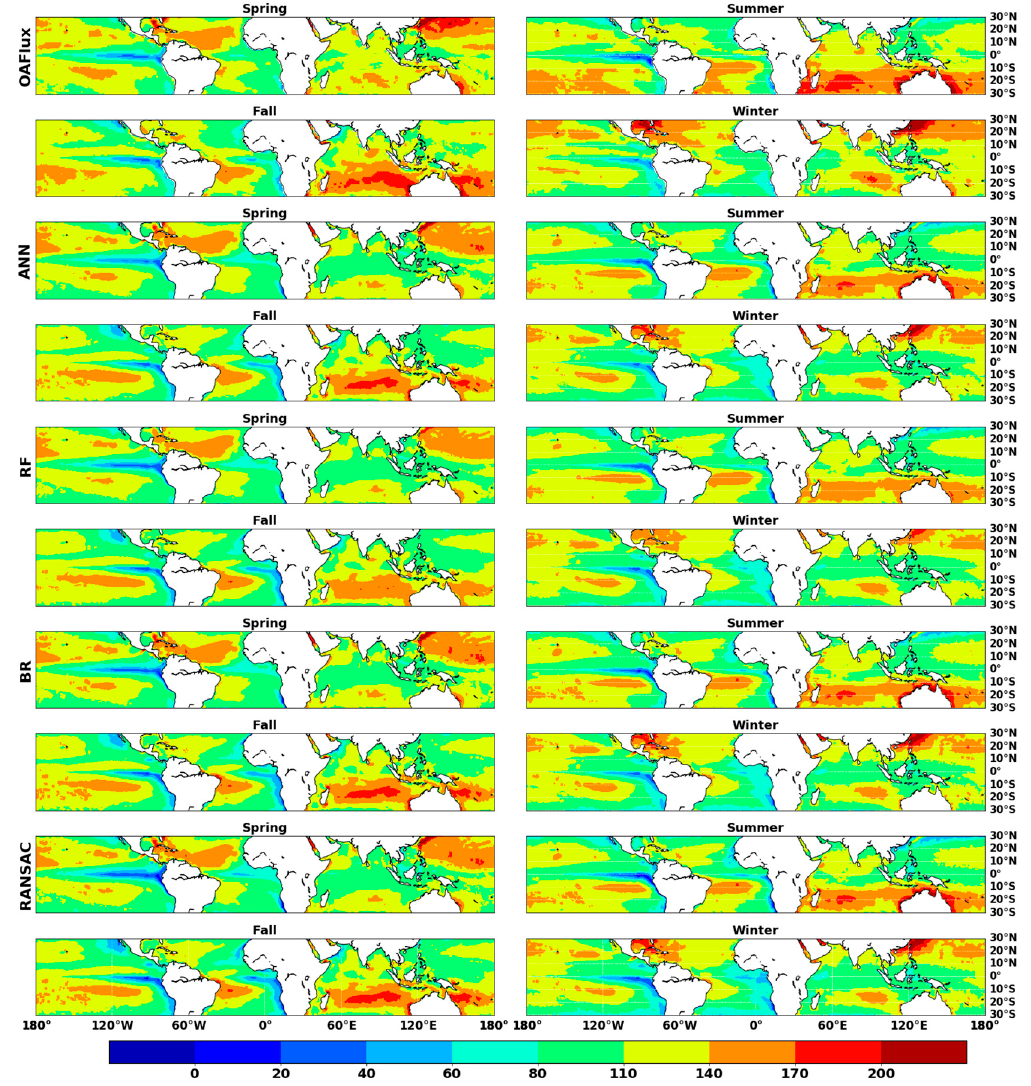
Figure 12. Maps of multiyear (2003–2007) average seasonality of ocean LHF estimations from OAFlux product and four ML methods (unit W m − 2 ).